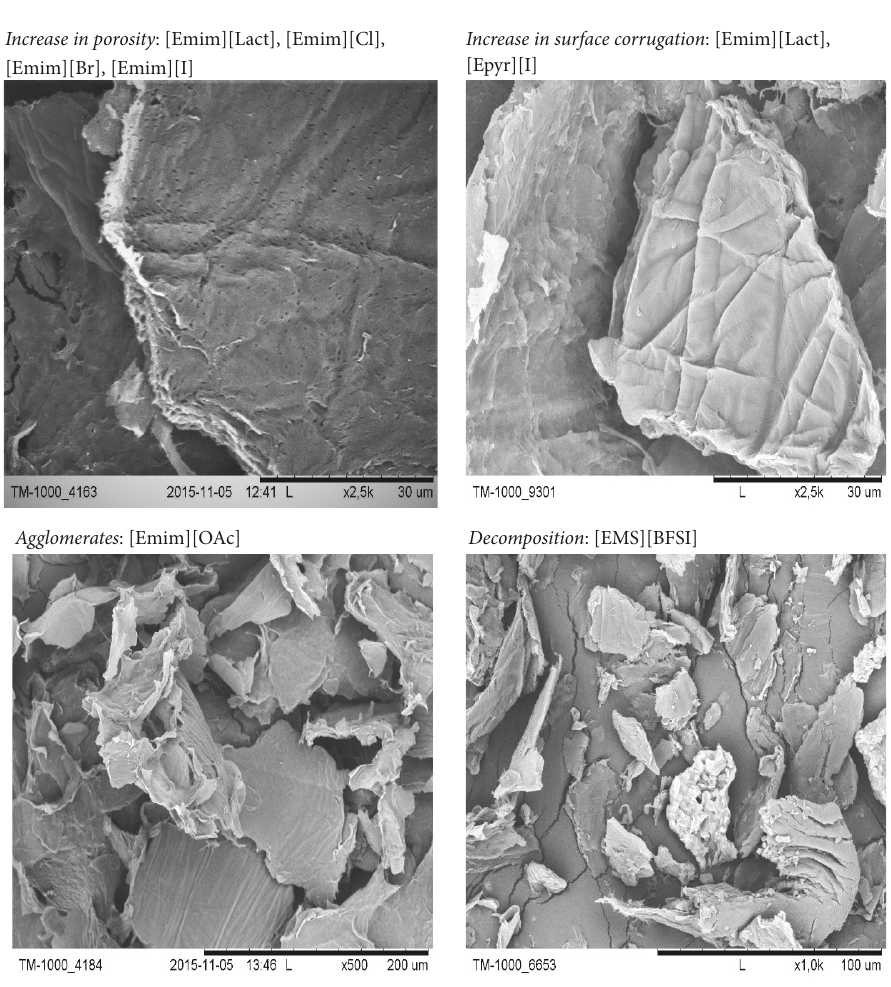
Figure 2: Typical changes in structure of regenerated chitin